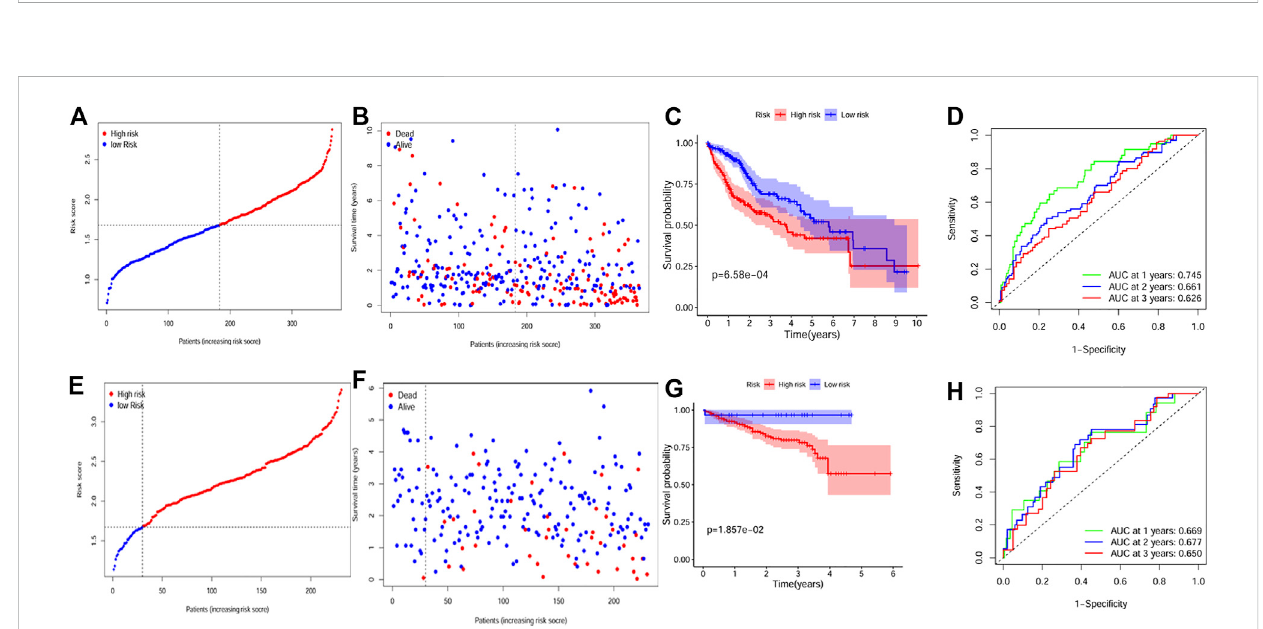
FIGURE 3 Construction and validation of the gene signature. (A, B) The distribution of risk score and survival status for the TCGA dataset. (C) Survival analysis between thehighandlowriskgroupsfortheTCGAdataset. (D) ROC curvesshowingthepredictivevalueoftheriskscorefor theTCGAdataset. (E, F) The distributionofriskscore andsurvival statusfortheICGC dataset. (G) Survivalanalysisbetweenthehighandlow riskgroupsfor theICGC dataset. (H) ROC curves showing the predictive value of the risk score for the ICGC